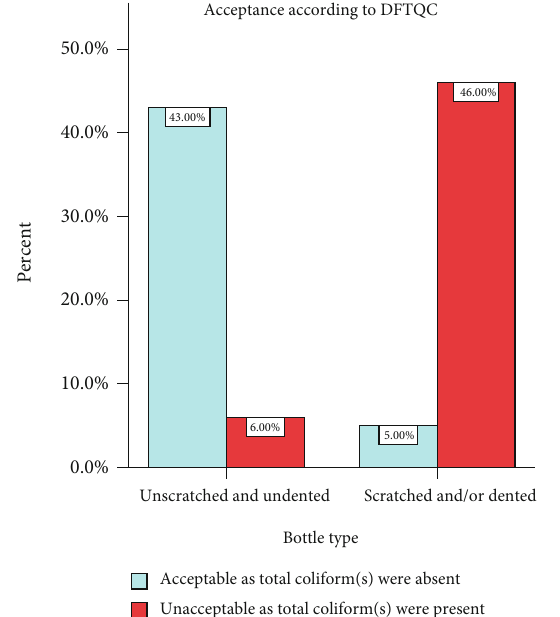
Figure 5: Distribution of total coliform with respect to the physical condition of the bottled water vessel.